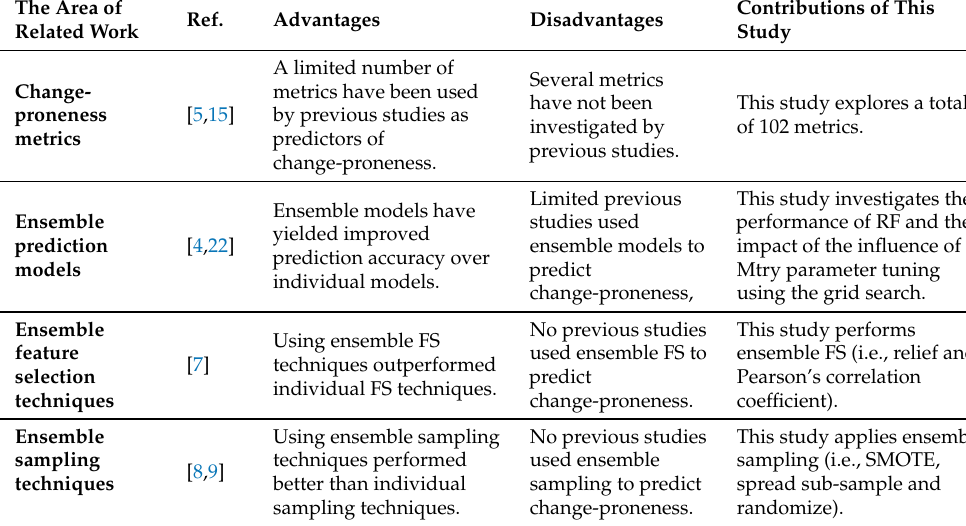
Table 1. Summary of the related work.